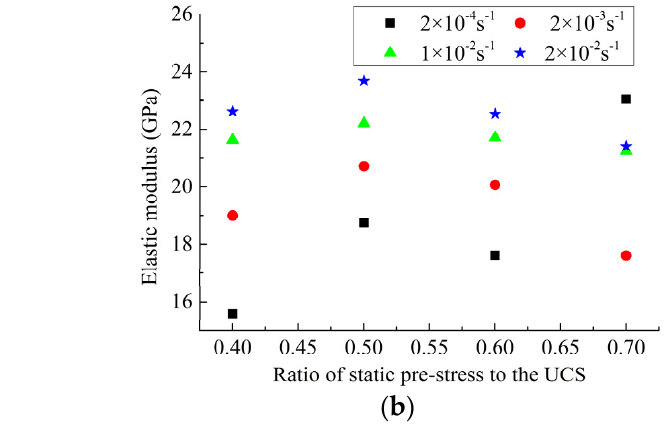
Figure 6. The ( a ) strength and the ( b ) elastic modulus influenced by the static pre-stress. At the same dynamic loading rate, the elastic modulus reaches the peak when the Table 3. The experimental results of superimposed static and dynamic loading rates. static pre-stress is 50% of the UCS. When static pre-stress is increased from 40% of the UCS to 50% of the UCS, the specimens are more compressed and some of the pre-existing cracks and micro-pores in the specimens are further closed, leading to the increment in elastic modulus. However, when the static stress is increased from 50% of the UCS to 70% of the UCS, the effect of static pre-stress on the elastic modulus becomes negligible. In addition, the higher the static pre-stress, the weaker the effect of the dynamic loading strain rate on the elastic modulus. Therefore, the elastic modulus increases first and then decreases with increasing static